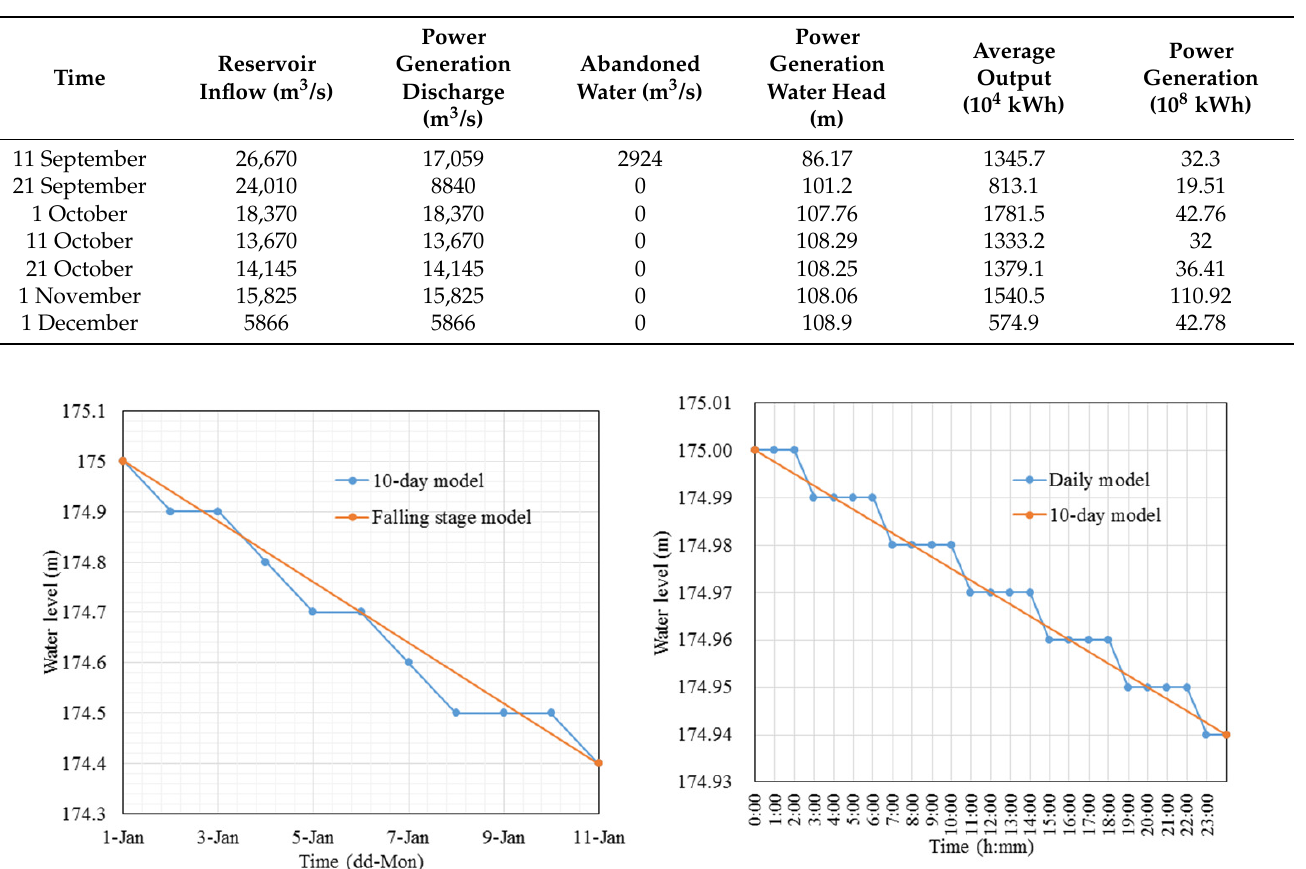
Table 7. Implementation effect statistics of impounding stage scheduling scheme for TG reservoir (varying scheduling intervals).